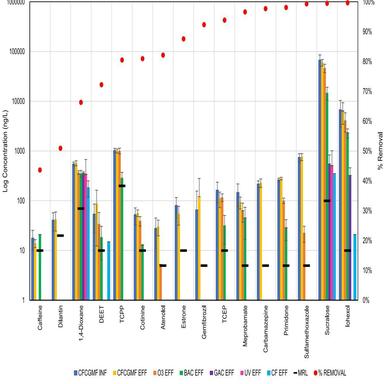
The concentration of contaminants of emerging concern (CECs) listed under monitoring at each treatment barrier (colored bar plots): CFCGMF influent and effluent, ozone effluent (O3 EFF), BAC filter effluent (BAC EFF), GAC filter effluent (GAC EFF), UV irradiation effluent (UV EFF), and cartridge filtration effluent (CF EFF), and percentage removal up to the indicated barrier (red dots). Thick black bars represent the laboratory's minimum report level (MRL) for each pollutant.